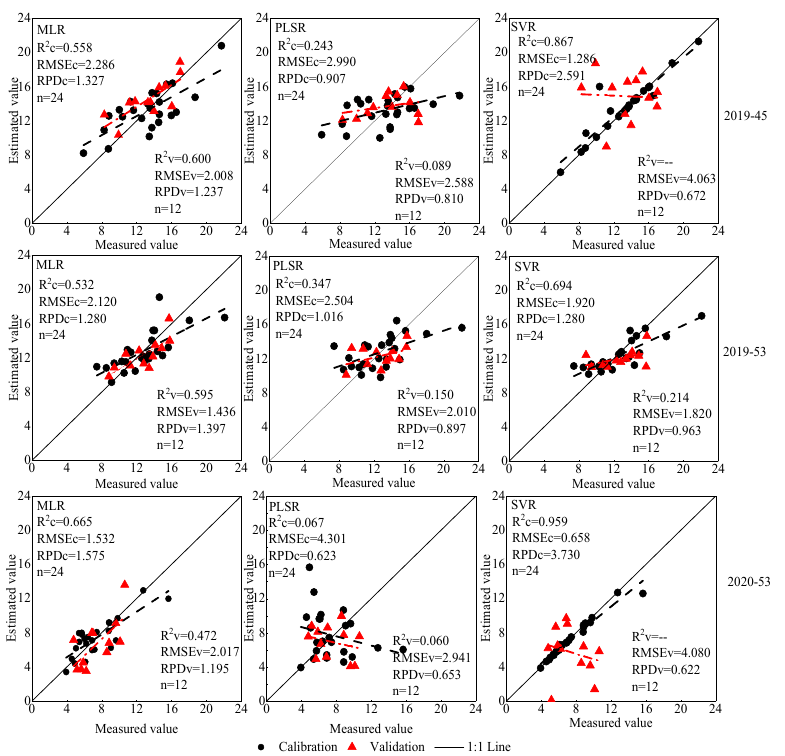
Figure 11. Parameters of CND for the estimation and verification of the model of drip ‐ irrigation cotton at full ‐ boll period based on vegetation index.